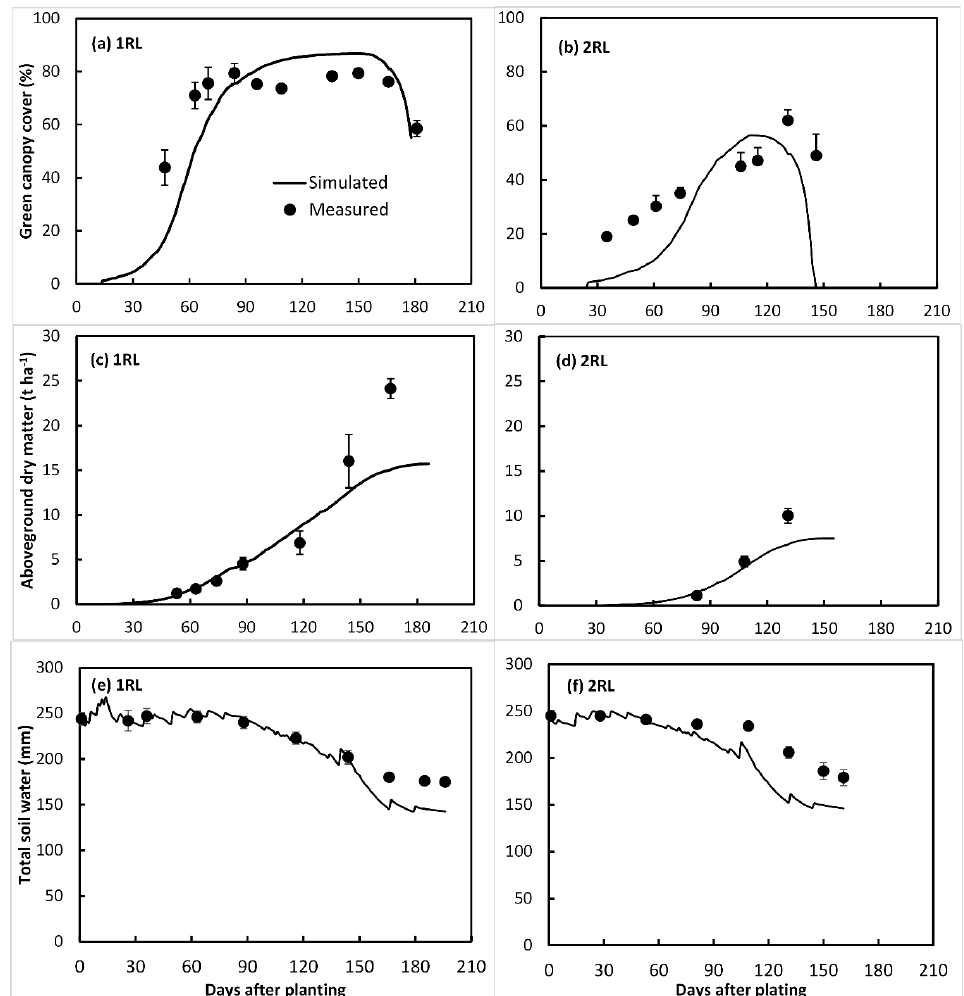
Figure 9. Measured and simulated green canopy cover (CC), above-ground dry matter (AGDM), and total soil water (TSW) for an early sown (1RL) and late sown (2RL) un-irrigated faba bean. 1RL stands for sowing date 1 (21 April), rainfed, low sowing rate (21 plants m − 2 ); 2RL stands for sowing date 2 (26 May), rainfed, low sowing rate (21 plants m − 2 ). ( a ) Measured and simulated CC for 1RL; ( b ) measured and simulated CC for 2RL; ( c ) measured and simulated AGDM for 1RL; ( d ) measured and simulated AGDM for 2RL; ( e ) measured and simulated TSW for 1RL; ( f ) measured and simulated TSW for